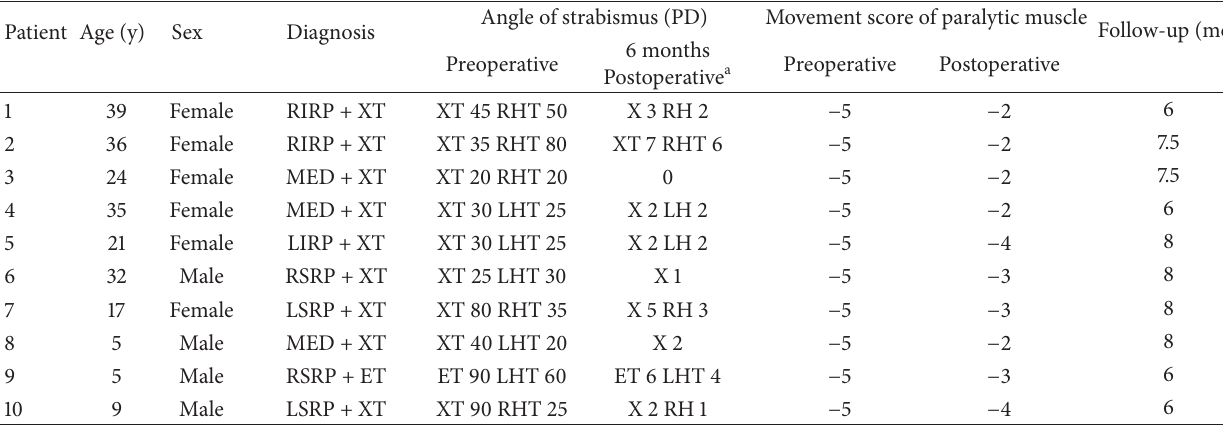
Table 1: Patient characteristics.